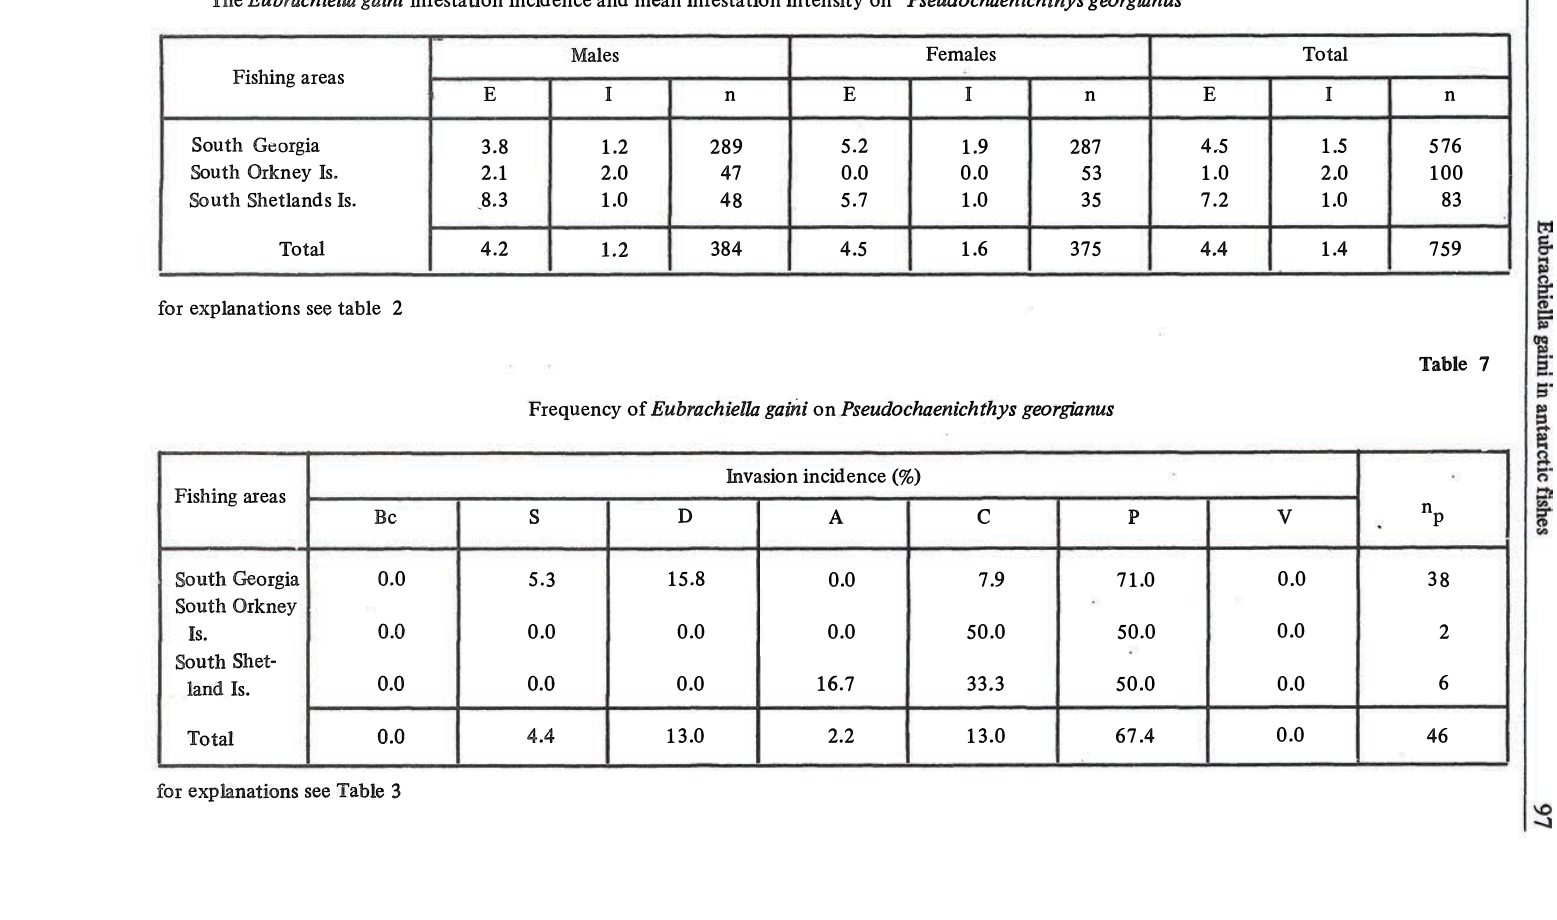
The Eubmchiella gaini infestation incidence and mean infestation intensity on Pseudochaenichthys